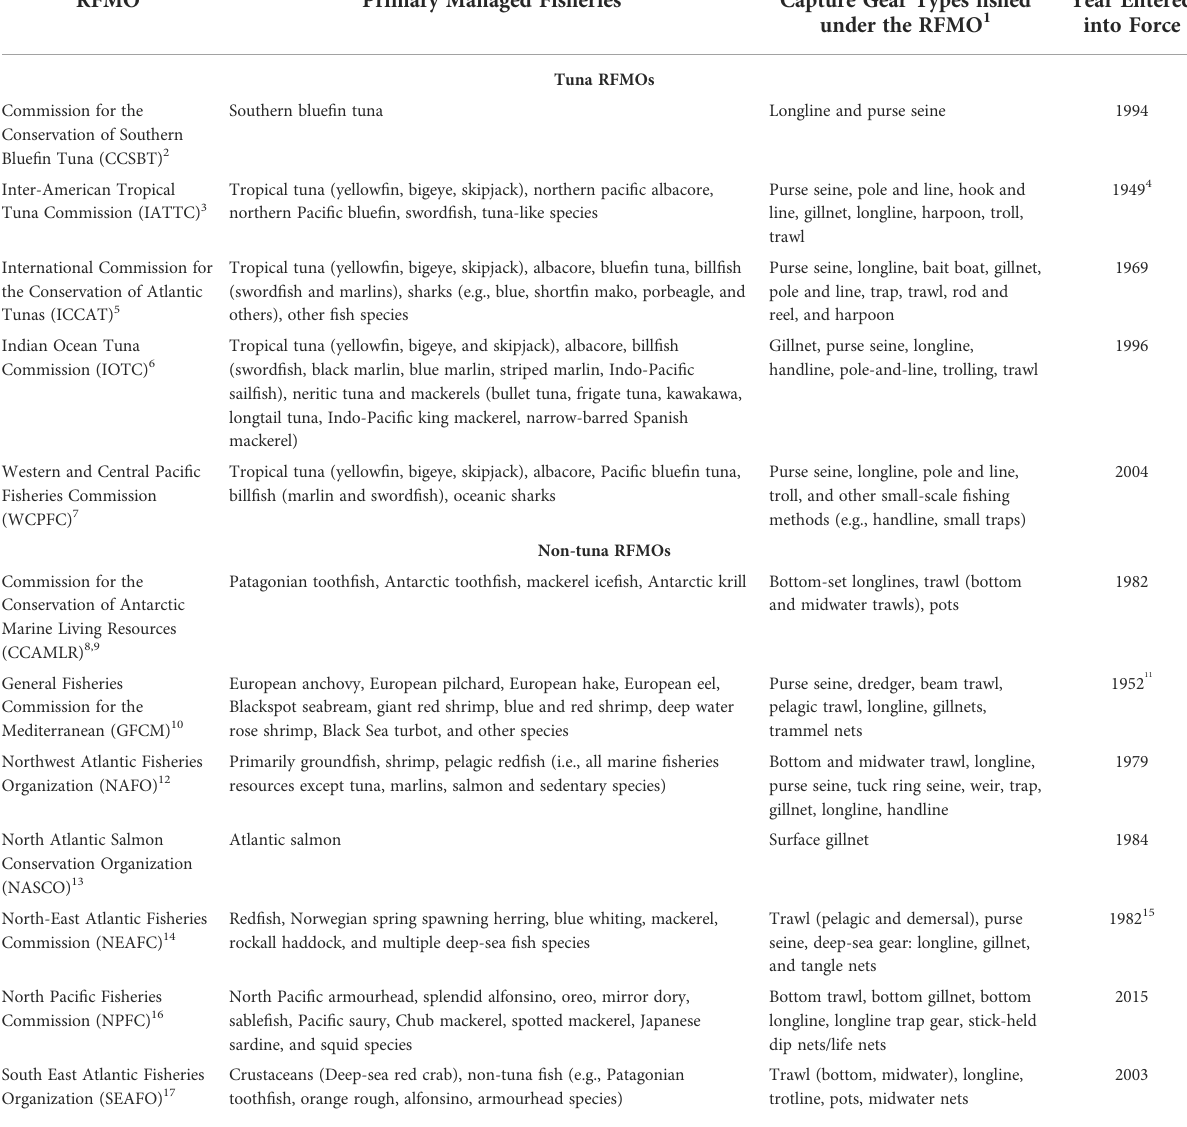
TABLE 1 List of RFMOs reviewed in this study.